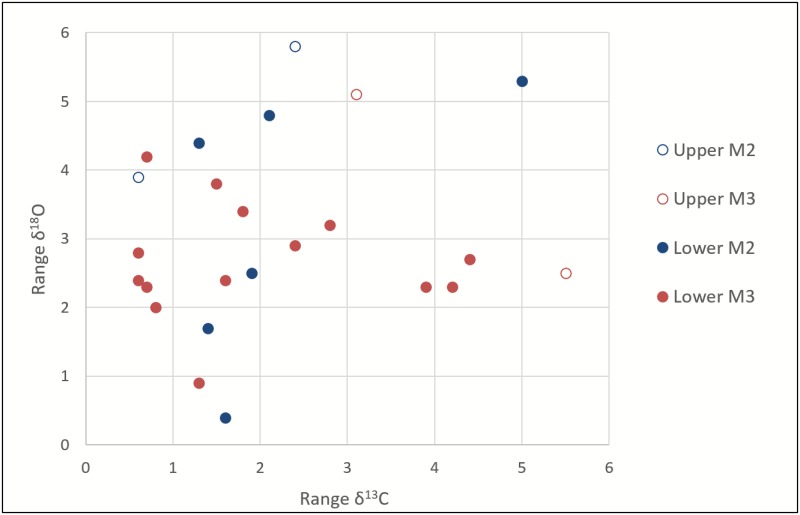
Scatter plot of ranges of δ18O and δ13C values in cervids and caprids by upper and lower molars showing no relationship between tooth sampled and δ18O and δ13C values.